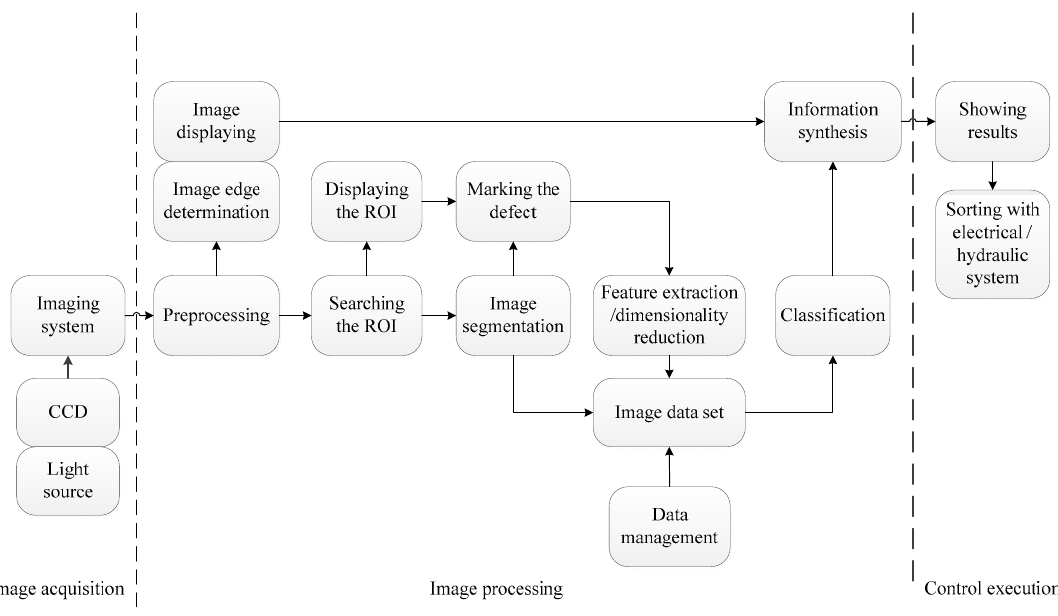
Figure 1. Visual inspection system. Note: CCD: Charge coupled devices; ROI: Region of interest.